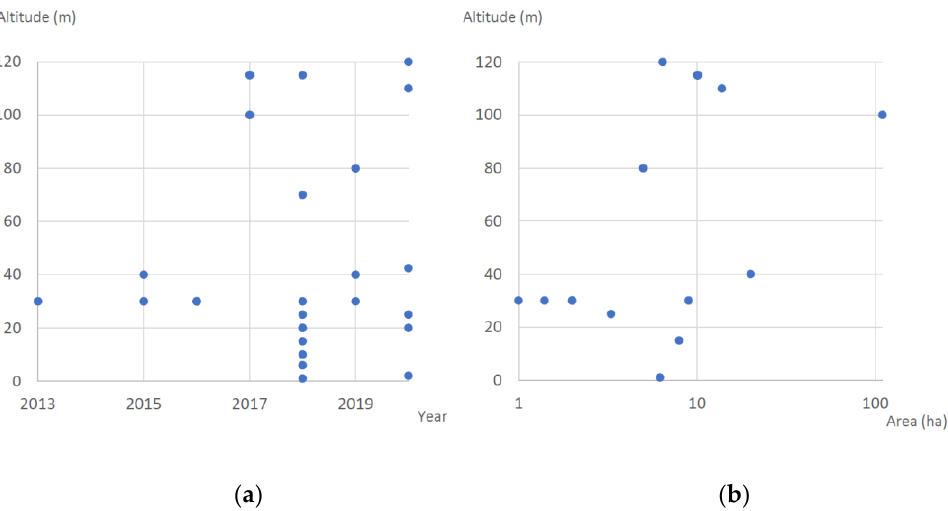
Figure 1. Information regarding flying altitudes based on reviewed publications: ( a ) main flying altitudes in the articles related to publication years (one case in 2012 with an altitude of 400 m was excluded); ( b ) the mapped hectares (logarithmic scale) in relation to flying altitudes.